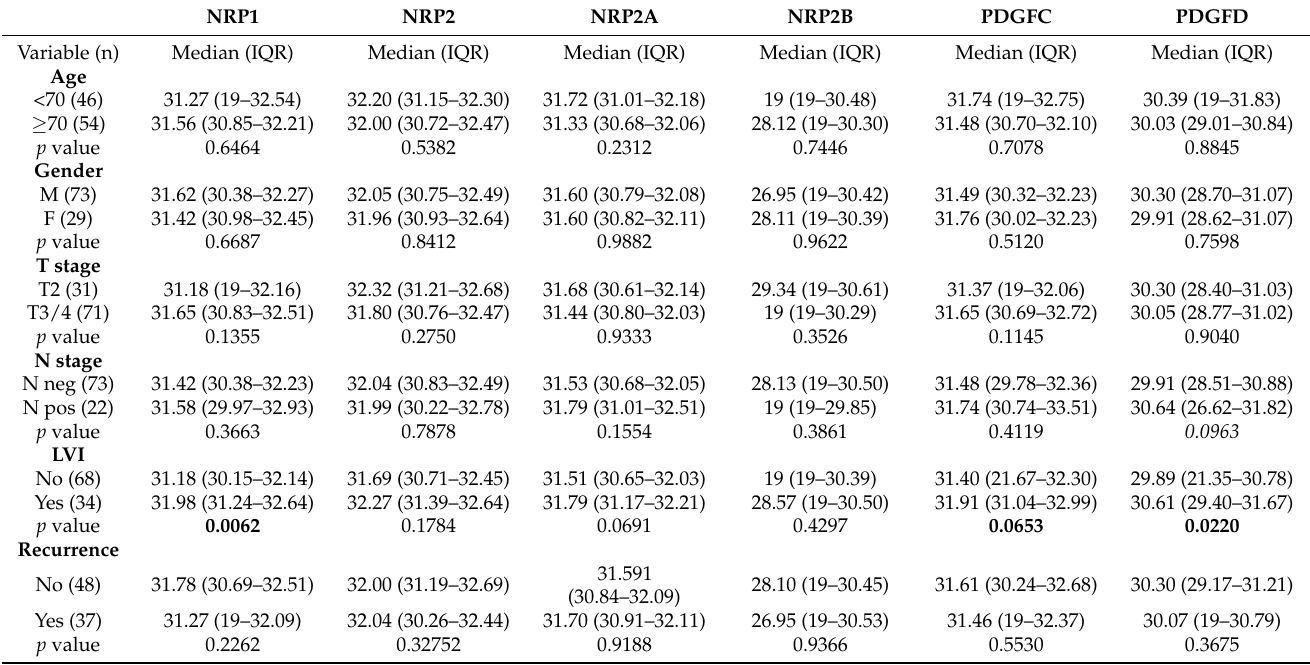
Table 3. Associations of gene expression with clinicopathological parameters in the Mannheim